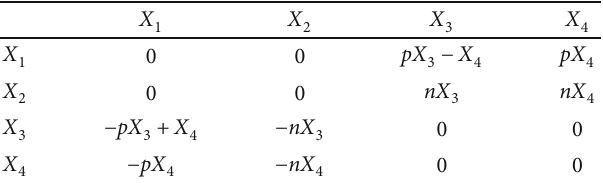
Table 2: The adjoint representation of X